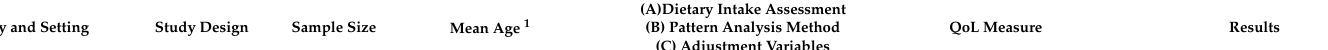
Adherence to MD is positively related to both PCS and MCS of SF12 for both sexes.